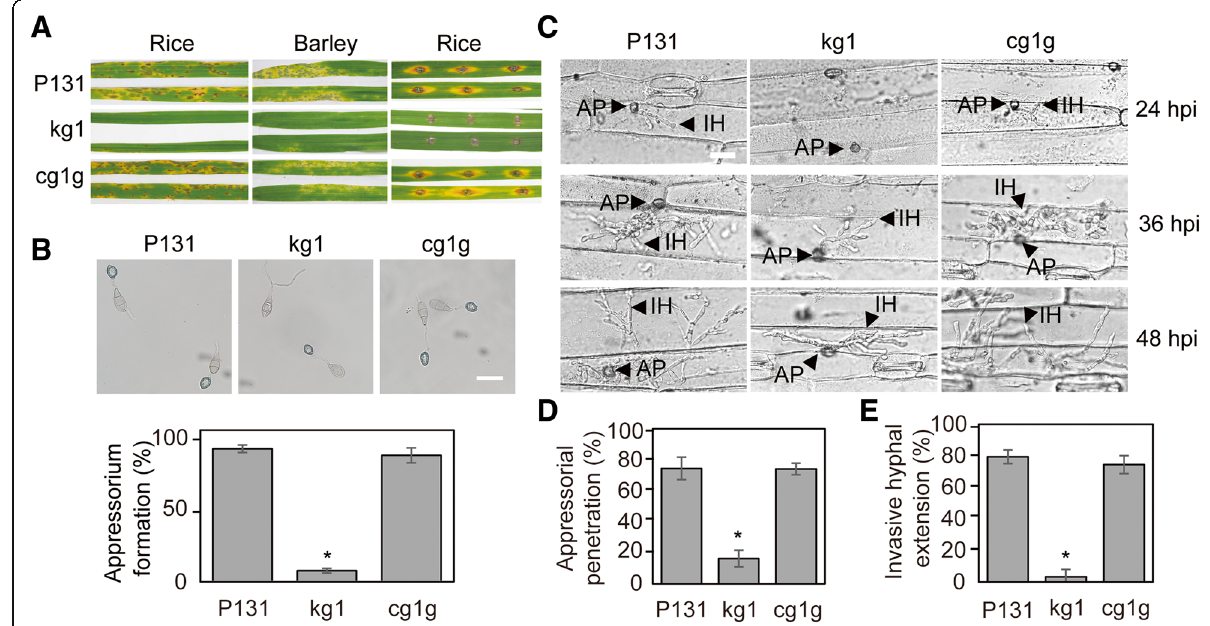
Fig. 3 MoGRP1 is required for plant infection and infection-related morphogenesis. a Disease lesions formed on rice seedlings (left panel), barley seedlings (middle panel), and abraded rice leaves (right panel) by inoculation of the wild-type strain P131, the Δ Mogrp1 mutant kg1, and one Δ Mogrp1 complementation transformant cg1g. Typical disease lesions were photographed at 5 – 7 dpi; b Appressorium formation on glass coverslips (upper panel) and its percentages (lower panel) by strains P131, kg1, and cg1g at 12 hpi. The mean ± SD was calculated based on three independent experiments measuring at least 100 germinated conidia in each replicate. Bar, 20 μ m. * P < 0.05; c Appressorium-mediated penetration and invasive hyphal development in epidermal cells of barley leaves by strains P131, kg1, and cg1g at 24, 36, and 48hpi. Bar, 20 μ m; d Column diagram showing the percentage of penetration pegs forming invasive hyphae in the epidermal cells of barley leaves by strains P131, kg1, and cg1g at 24 hpi. The mean±SD was calculated based on three independent experiments measuring at least 100 appressoria in each replicate. * P <0.05; e Column diagram showing the percentage of invasive hyphae extending into neighboring cells in the epidermis of barley leaves by strains P131, kg1, and cg1g at 48hpi. The mean±SD was calculated based on three independent experiments measuring at least 60 infection sites in each replicate. * P